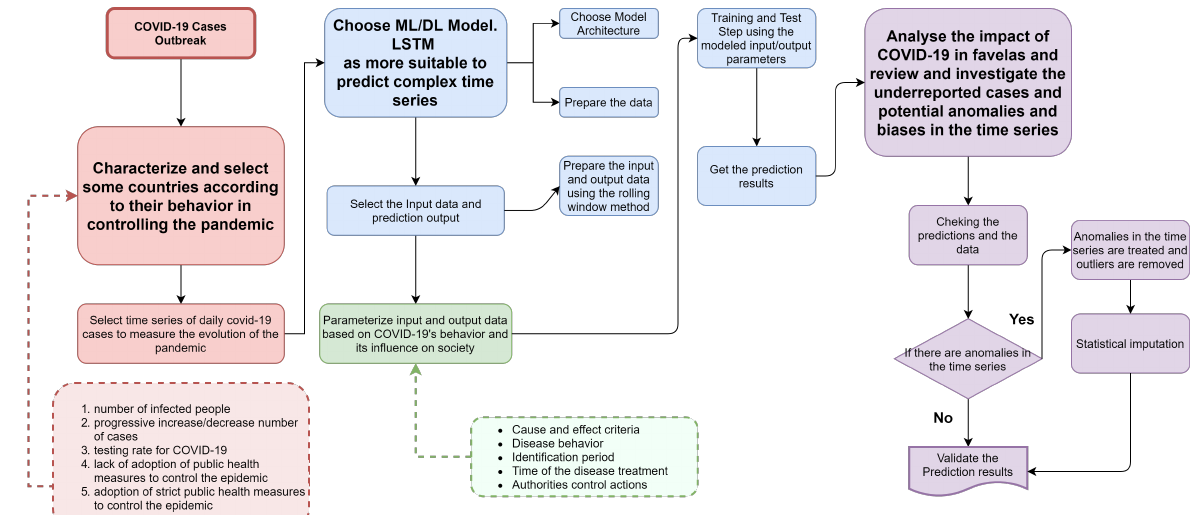
Figure 1. Methodology overview diagram. In this figure, we focus on the main steps to treat the data, choose the model parameters and validate the model with an statistical imputation